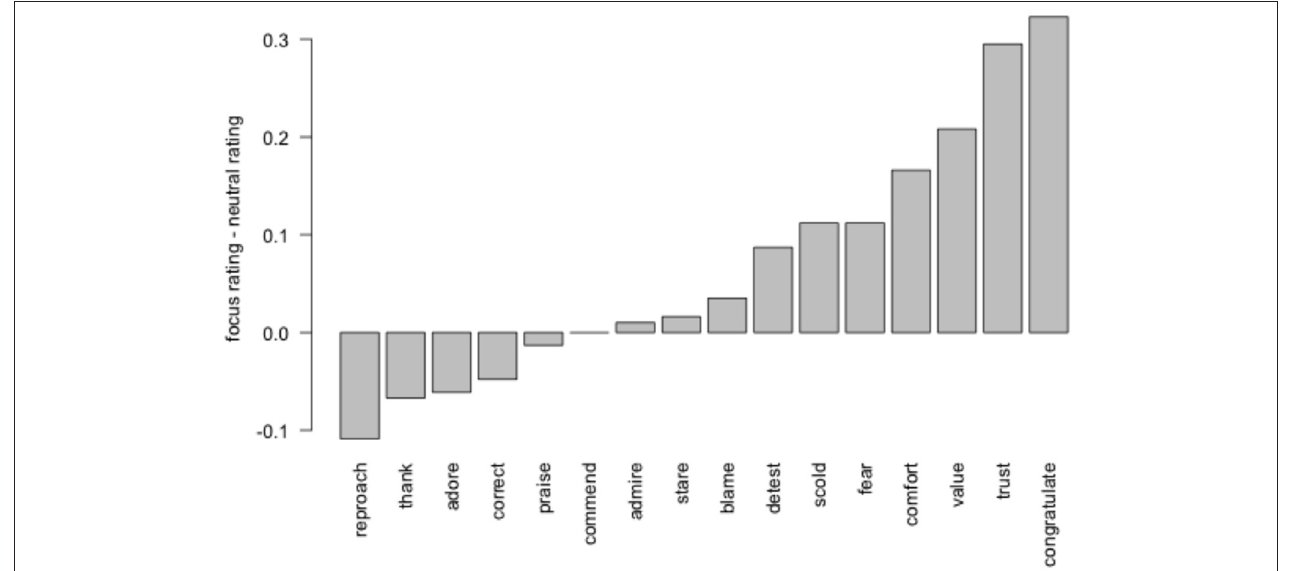
FIGURE 3 | Subject coreference in Experiment 3, by